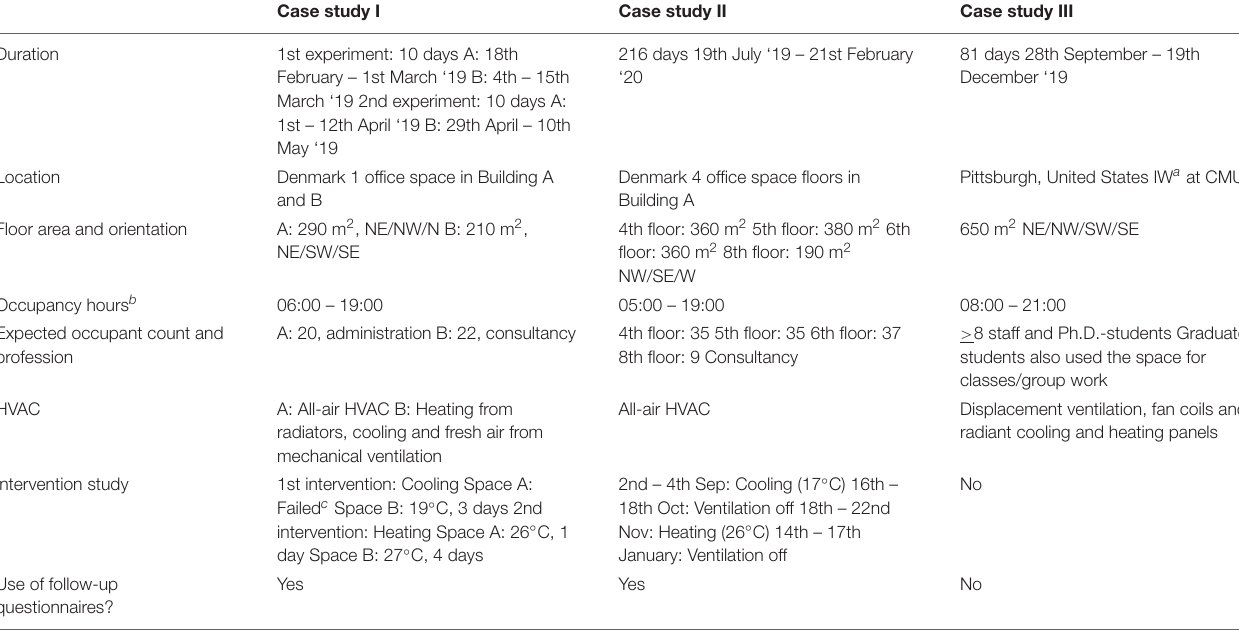
TABLE 1 | Overview of study design and use of